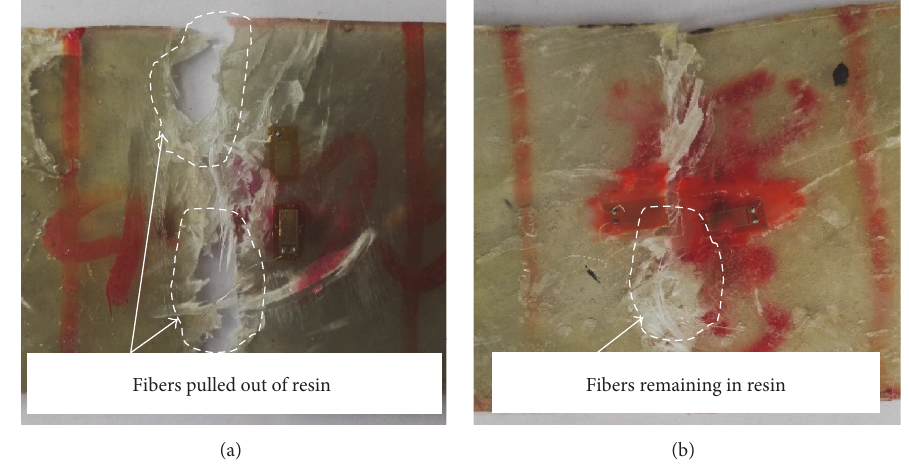
Figure 9: Failure modes of fibers along the through crack.